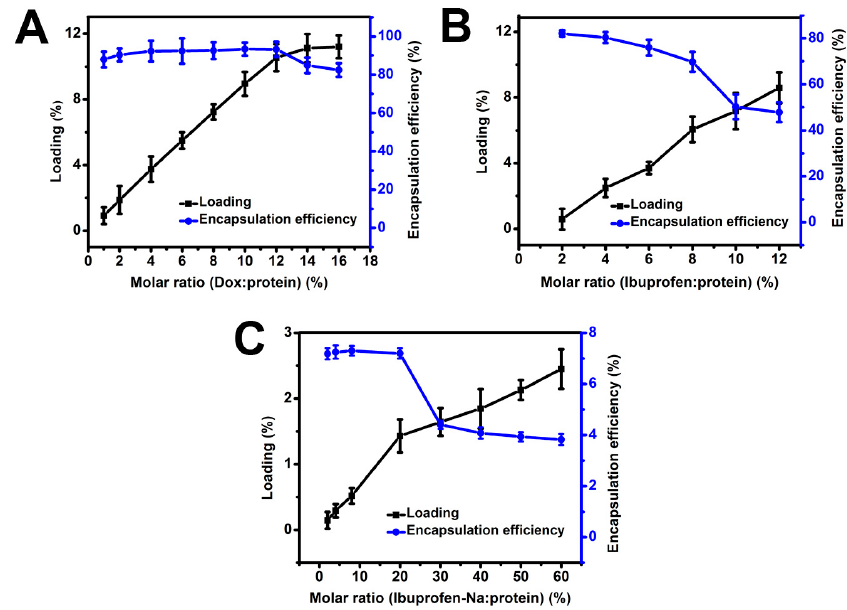
Figure 2. Drug loading and encapsulation efficiency of Ap F nanoparticles. ( A ) Doxorubicin ( B ) Ibuprofen and ( C ) Ibuprofen-Na loaded in Ap F nanoparticles.